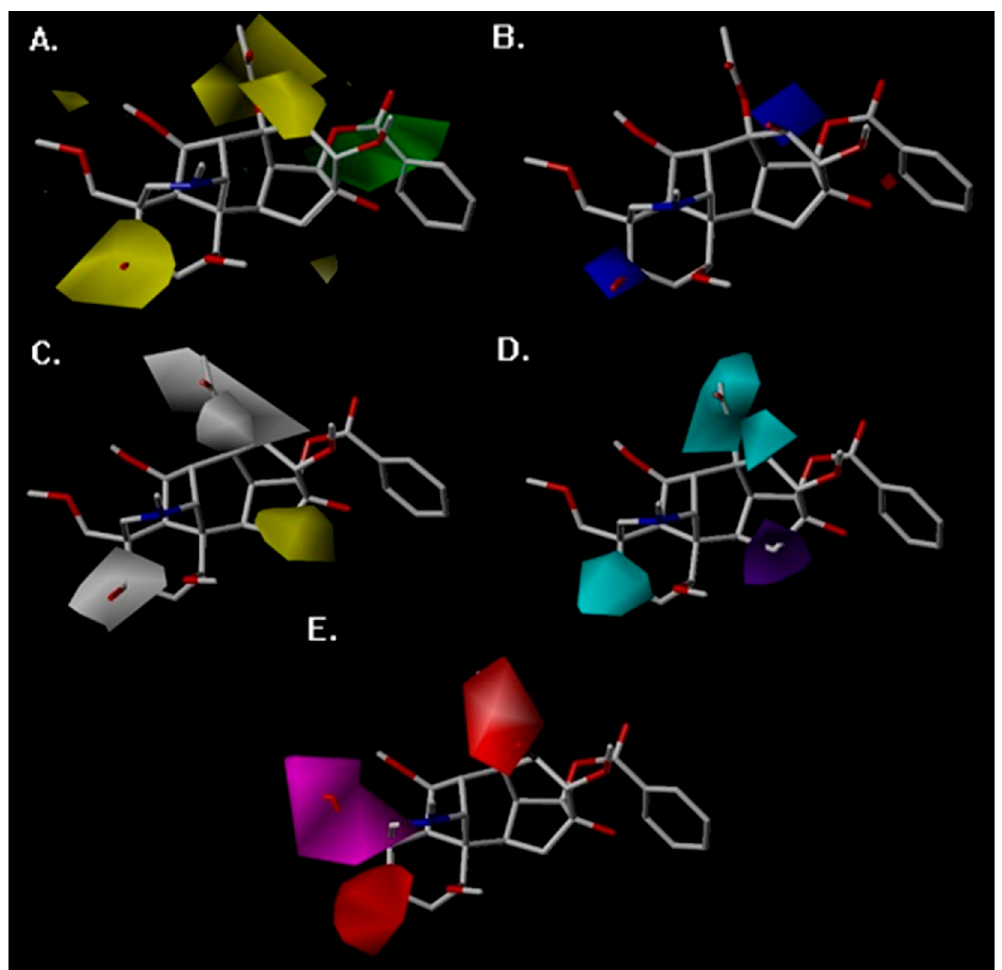
Figure 6. CoMSIA and CoMFA contour maps around Compound 6 . ( A ) The CoMFA steric contour map, ( B ) the CoMFA electrostatic contour map, ( C ) the CoMSIA hydrophobic field contour maps, ( D ) the CoMSIA hydrogen bond donor field, and ( E ) the CoMSIA hydrogen bond acceptor field.